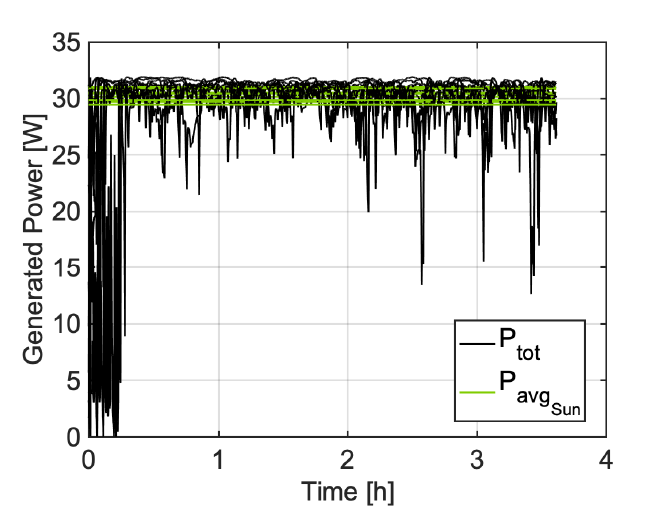
Figure 8. Solar arrays power Monte Carlo analysis, with no eclipses and momentum exchange actua- tors.